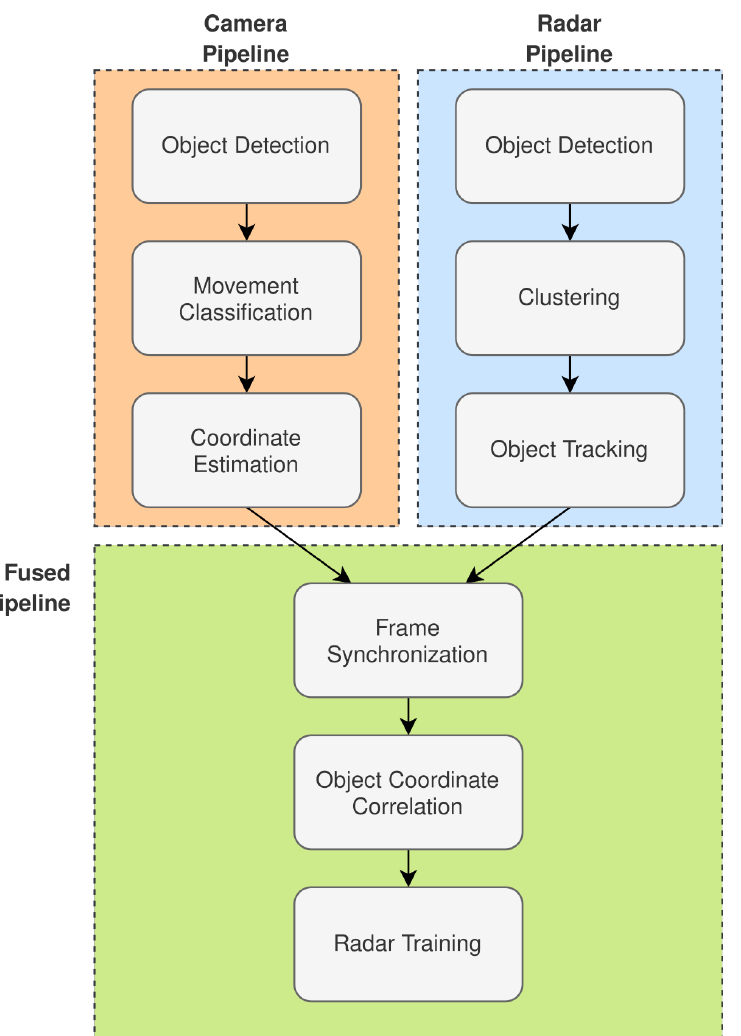
Figure 3. Radar-tracking system design with a human-movement-pattern classifier trained with camera-labeled frames.